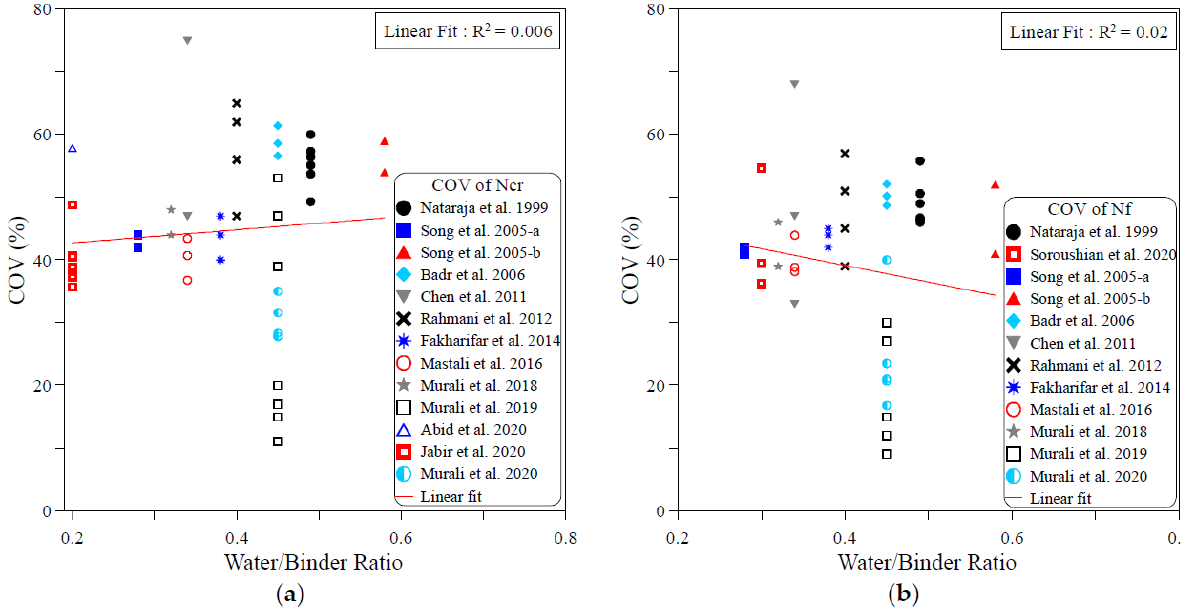
Figure 5. Effect of water–binder ratio on the scattering of impact results at ( a ) cracking and ( b ) failure.